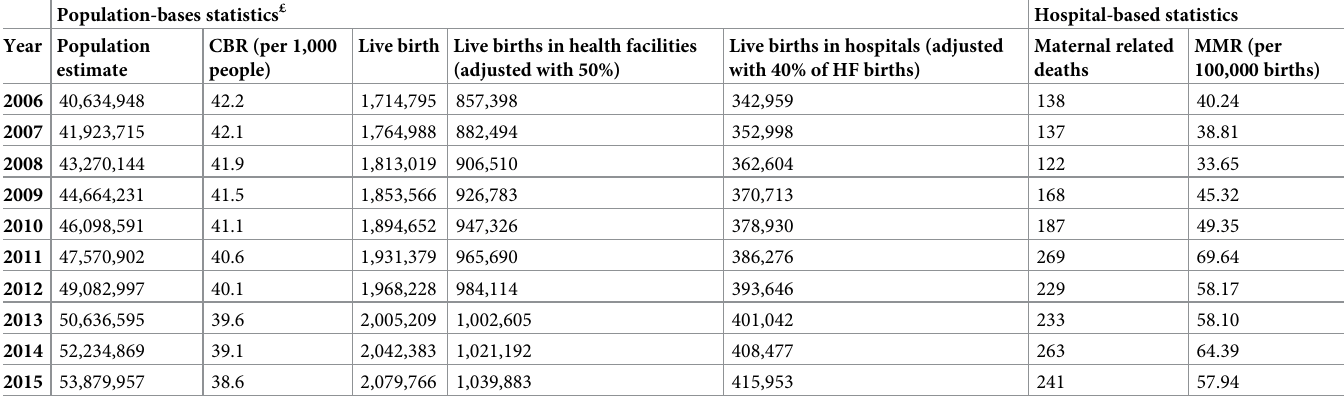
Table 2. Population estimate, crude birth rate (CBR), live birth, maternal related deaths and hospital-based maternal mortality ratio (MMR) per year. Population-bases statistics £